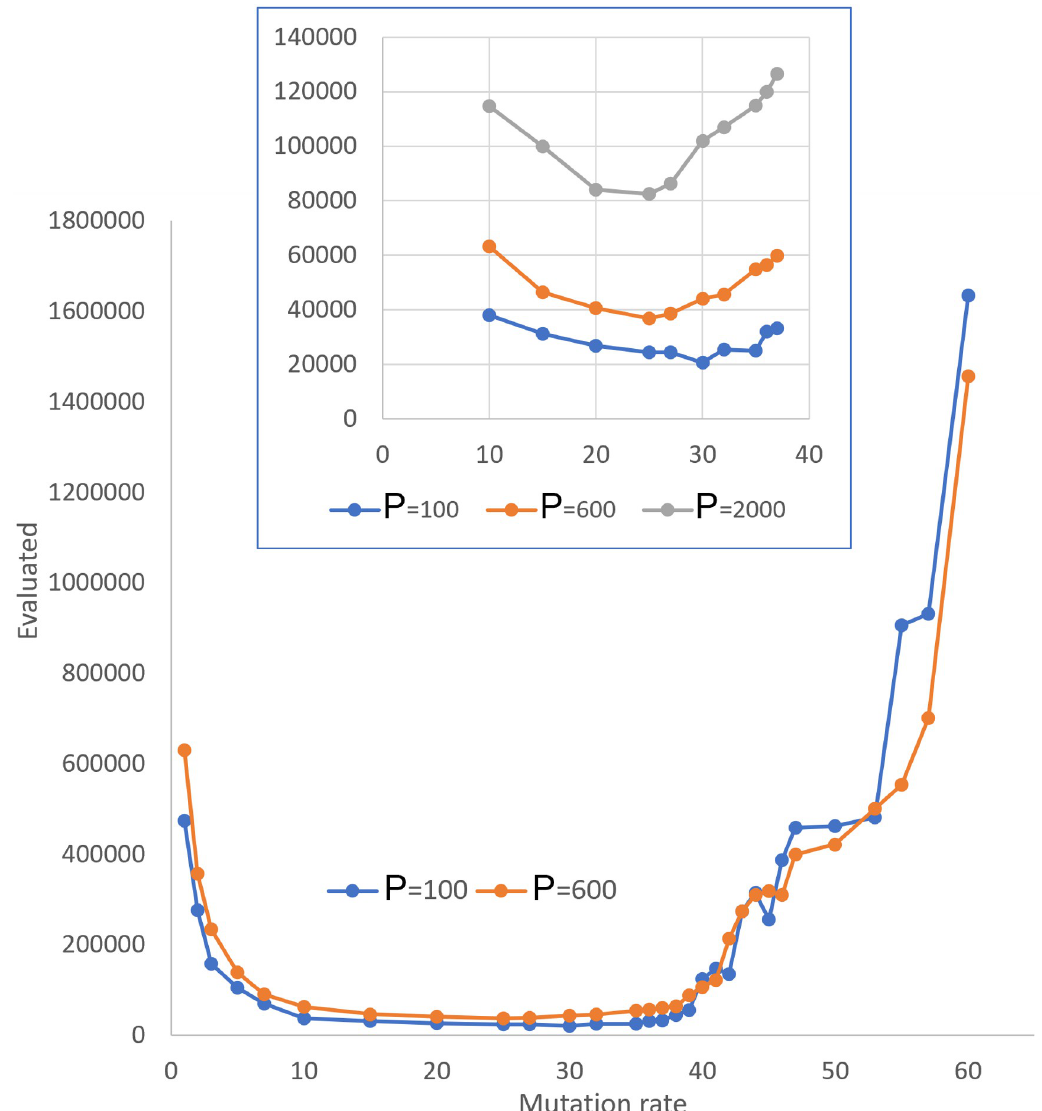
Fig 7. Effectiveness of evolutionary GA search (mutations only) with ( μ , λ ) selection, μ / λ = 0.4, 4 domains, 6+4 defined positions out of 26, W = 220 at varying mutation rate and population size as a function of mutation rate and population size. In inset the area of the robust algorithm work with low sensitivity to mutation rate is presented at three values of population size: P = 100, 600, and 2000. Within this area populations of low size are preferable. The mean number of fitness evaluations are computed over 100 runs per test. Standard deviations are of value comparable to the